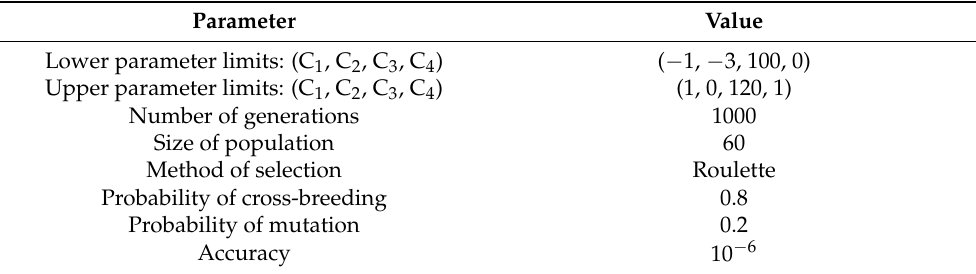
Table 1. Genetic algorithm parameters.